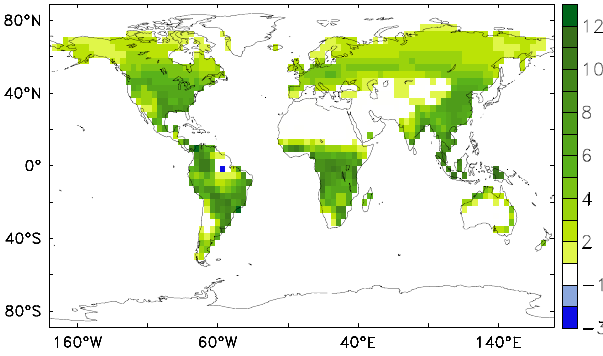
Fig. 6. Differences in Net Primary Productivity (NPP) caused by anthropogenic CO 2 emissions and vegetation dynamics in [mol(C)/m 2 yr] (DYN – CTL) averaged over the period from the year 2090 until 2119.